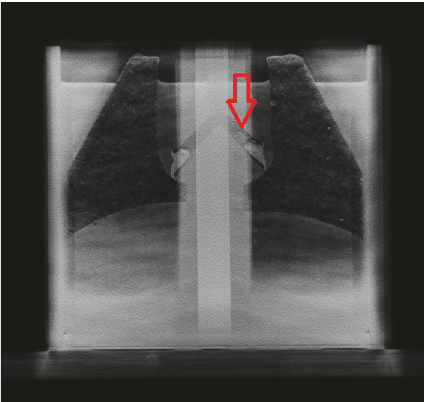
Figure 6: Visualization of a food particle in the airway. A recon- structed frame of the VolumeRAD acquisition for the second phantom with a low-density dry food particle lodged in the right airway bronchus (red